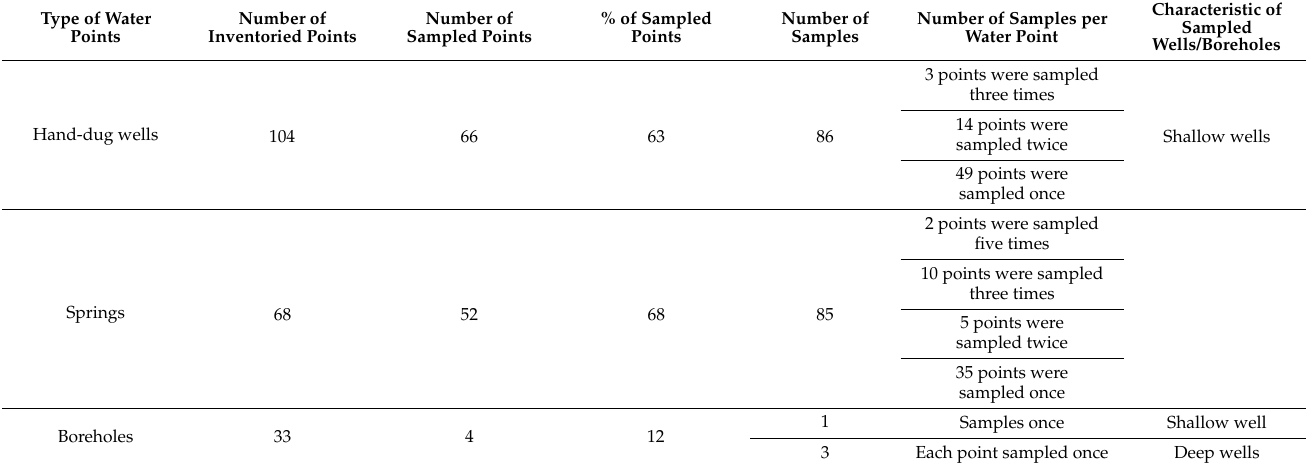
Characteristic of